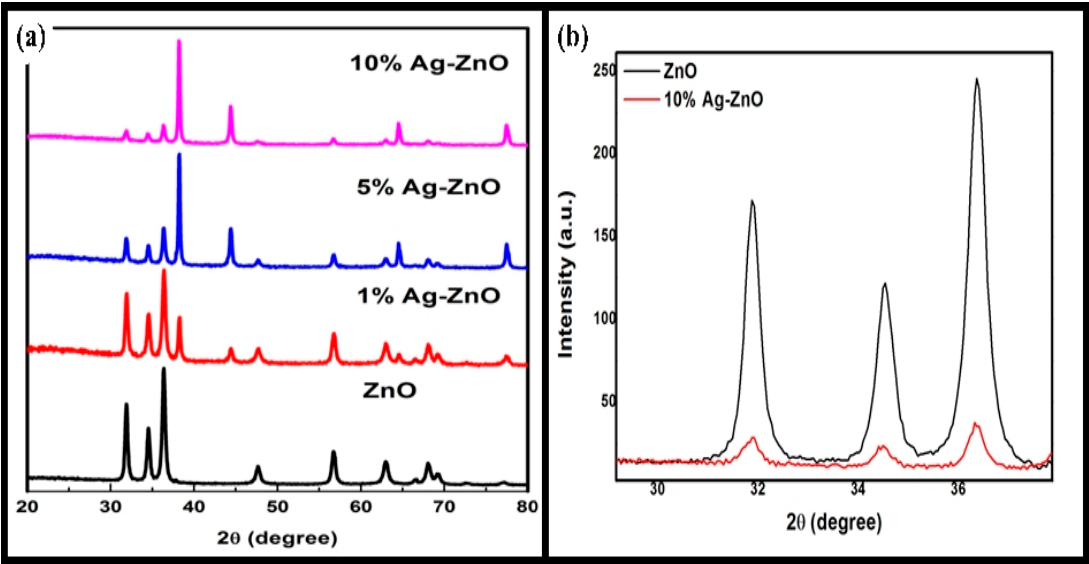
Figure 2. ( a ) XRD pattern of Ag x Zn 1 − x O nanostructure and ( b ) comparison of (100), (002) and (101) peaks from the XRD pattern of pure ZnO and 10% Ag-ZnO nanostructures.